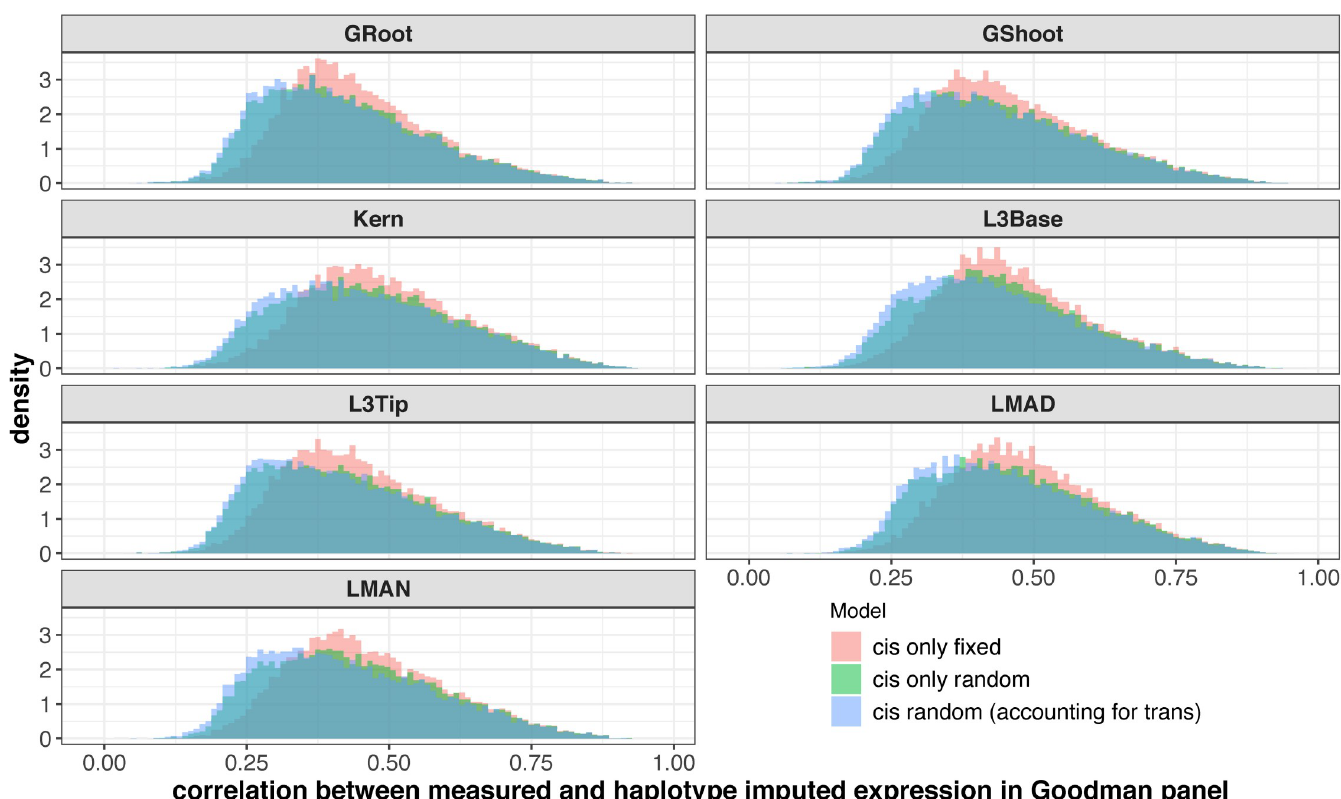
Fig 3. Haplotype associated RNA expression (HARE) was moderately correlated with measured RNA expression. The different colors represent HARE imputed from three statistical models: Model 1 ( cis fixed effect), 2 ( cis random effect), and 3 ( cis + trans random effects) across 7 diverse tissues: germinating seedlings root (GRoot), germinating seedlings shoot (GShoot), 2 cm from the base of leaf 3 (L3Base), 2 cm from the tip of leaf 3 (L3Tip), mature mid-leaf tissue sampled during mid-day (LMAD), mature mid-leaf tissue sampled during mid-night (LMAN), and developing kernels harvested after 350 growing degree days after pollination (Kern). Transcripts from measured RNA expression was a result of genetic signals in both trans and cis . Therefore, the correlation was moderate for most of the genes.